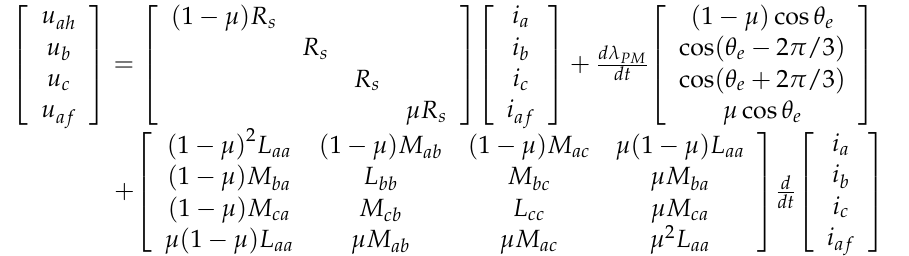
Figure 2. Electrical model of PMSG with ISF in phase a. From reference [30], the mathematical model of PMSG with ISF can be expressed in (4), where R s is stator resistance, θ e is electrical angle. L and M are self and mutual induct- ance of stator winding respectively, λ PM is the PM flux linkages.